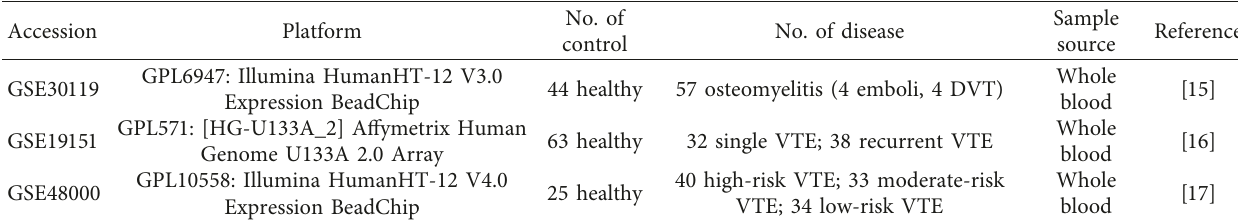
Table 1: Published datasets related to OM and VTE used in this study.